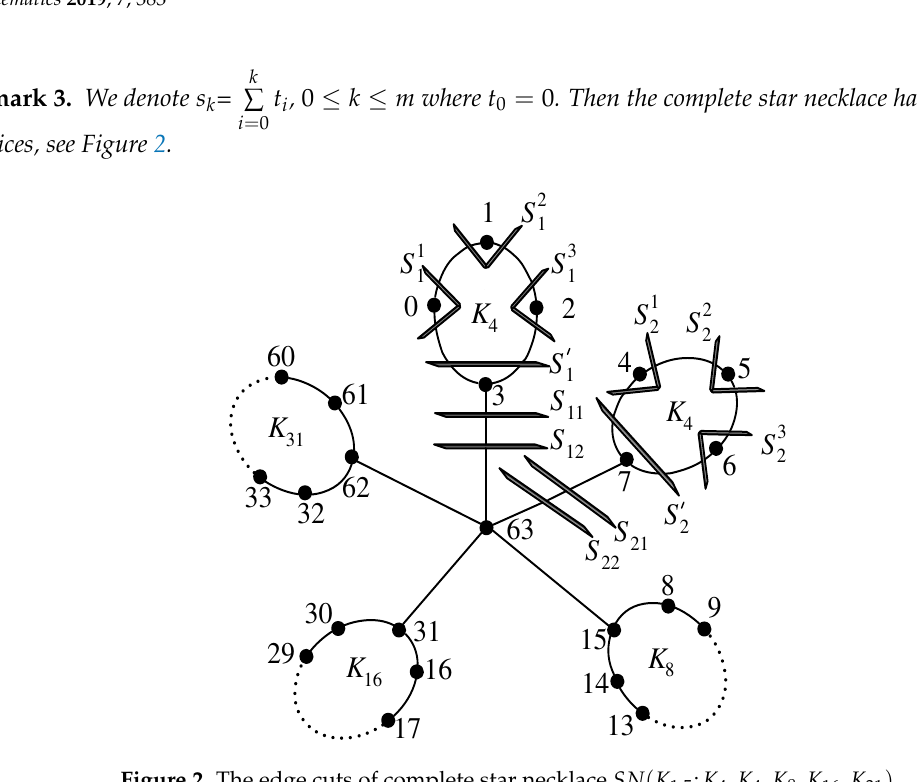
Figure 2. The edge cuts of complete star necklace SN ( K 1,5 ; K 4 , K 4 , K 8 , K 16 , K 31 ) .